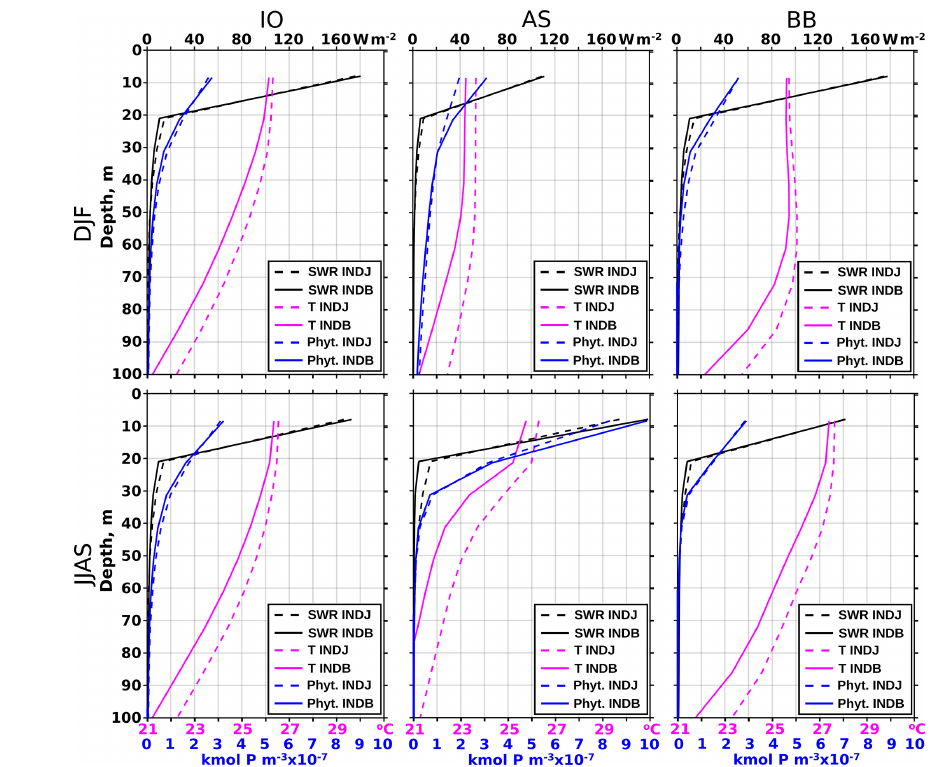
Figure 12. Vertical profiles of shortwave radiation (SWR), water temperature ( T ) and phytoplankton concentration (Phyt) in the INDJ and INDB